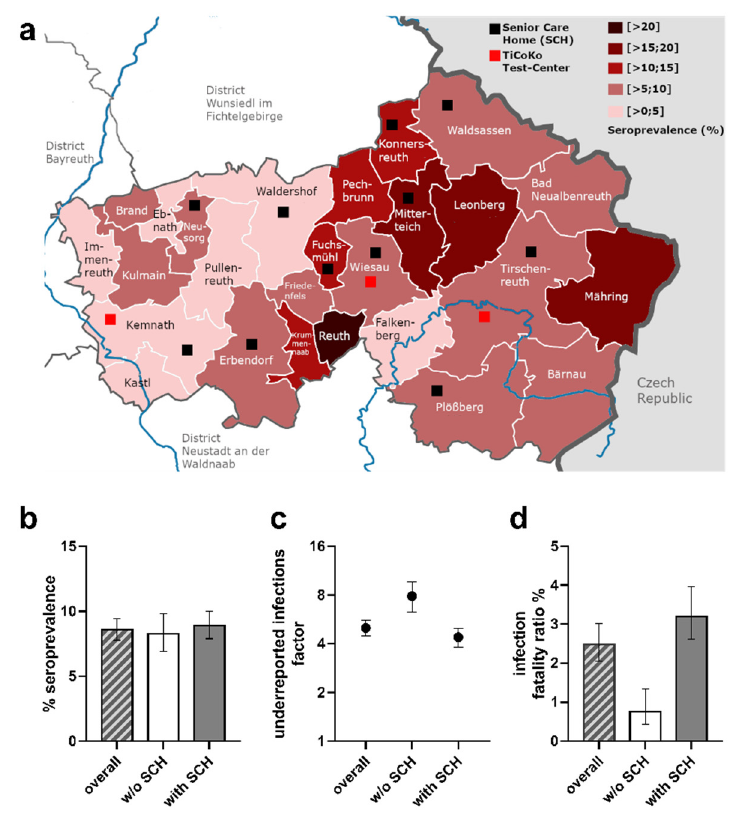
Figure 3. Seroprevalence, factor of underreported infections, and infection fatality ratios by munic- ipalities with and without senior care homes. ( a ) Standardized seroprevalence (%) determined for inhabitants of the local municipalities in county Tirschenreuth. ( b – d ) Standardized seroprevalence ( b ), factor of underreported infections ( c ) and infection fatality ratio ( d ) in the overall county popu- lation, in the population of local municipalities without senior care homes ( w/o SCH) and with senior care homes (with SCH). The 95% confidence intervals (95%-CI) are indicated, respectively. Red squares indicate the location of the study test centers, black squares highlight the municipality association of senior care homes. Figure was designed using GraphPad Prism version 8.4.3 for Win- dows, GraphPad Software, La Jolla, CA, USA, www.graphpad.com, and GIMP 2.10.22 for Windows, The GIMP Development Team, California, USA, www.gimp.org .